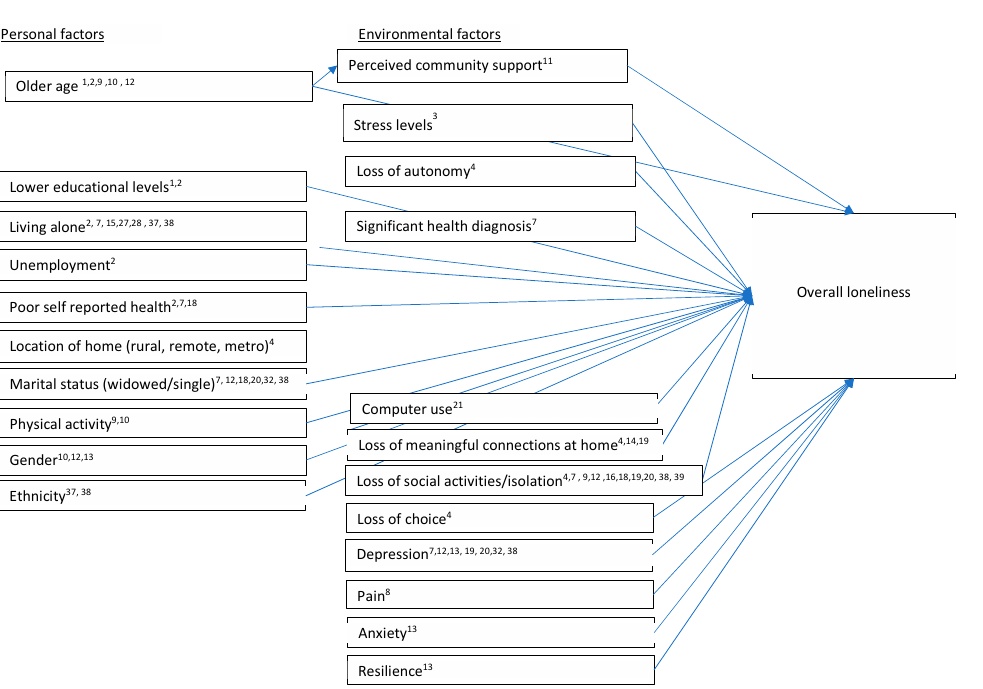
Figure 5. Antecedents to general loneliness. 1. Fierloos et al. (2021); 2. Gibney et al. (2019); 3. Nieboer et al. (2020), 4. Herron et al. (2022); 7. Fernandes et al. (2018); 8. Emerson et al. (2018); 9. Lin et al. (2016); 10. Gyasi et al. (2021); 11. Park et al. (2019); 12. Tomstad et al. (2017); 13. Lee et al. (2019); 14. Bai et al. (2017); 15. Teguo et al. (2016); 16. Wong et al. (2017); 17. Lay et al. (2020); 18. Teater et al. (2021); 19. Warner et al. (2019); 20. Ojagbemi et al. (2021); 21. Talmage et al. (2021) 27. Gyasi et al. (2019), 28. Evans et al. (2019); 32. Lam et al. (2017); 37. Jamieson et al. (2019); 38. Cheung et al. (2019).